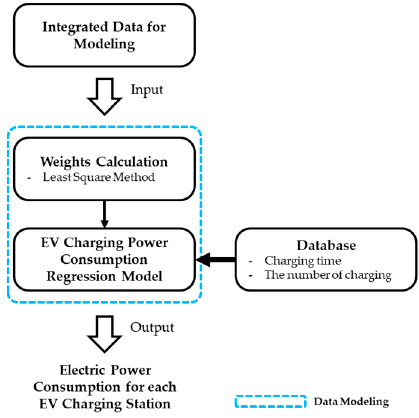
Figure 5. Overall process of data